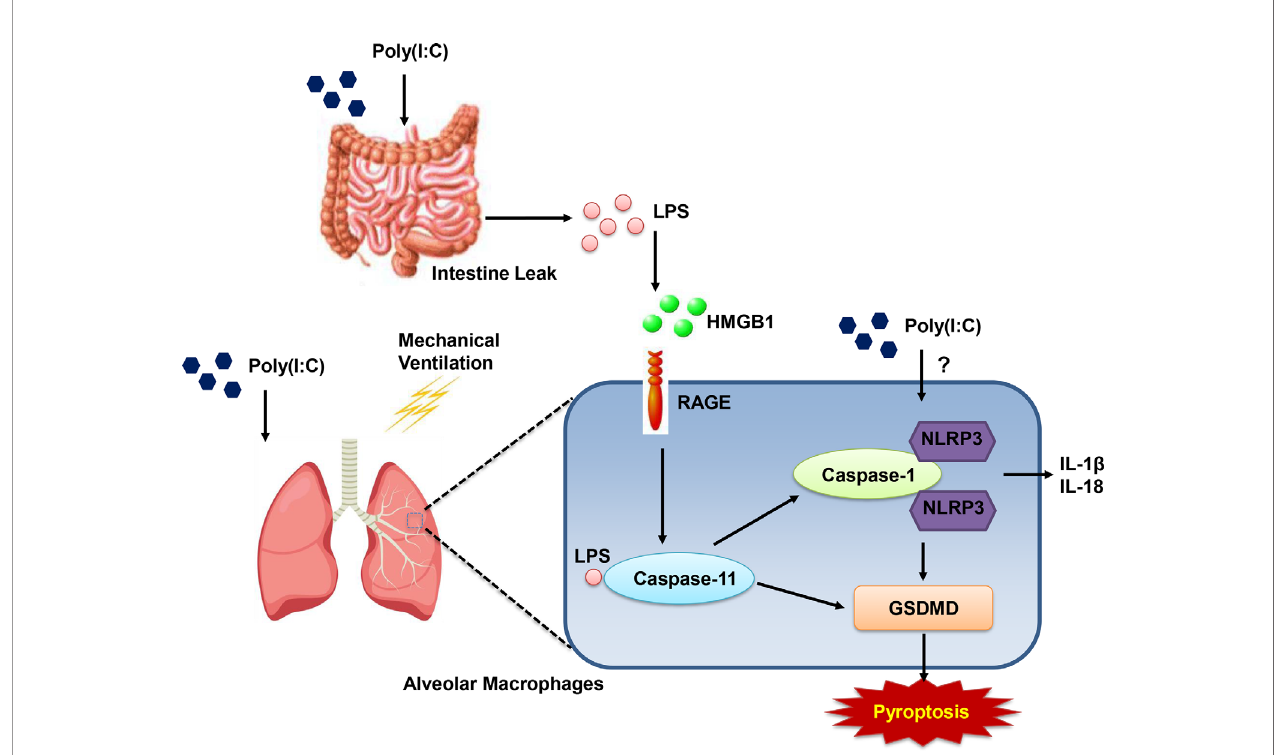
FIGURE 9 | Schematic graph of gut-lung axis. Combined (Poly(I:C)-MTV) insult results in increase in gastrointestinal permeability and endotoxin in plasma and BALF. Poly(I:C)+MTV insult was sensitive to Caspase-11 deletion with no further contribution of caspase-1 but led to large increases in procaspase 11 and its cleaved product as well as cleaved product of caspase-1. Genetic ablation of Gasdermin D (GSDMD) attenuated alveolar-capillary